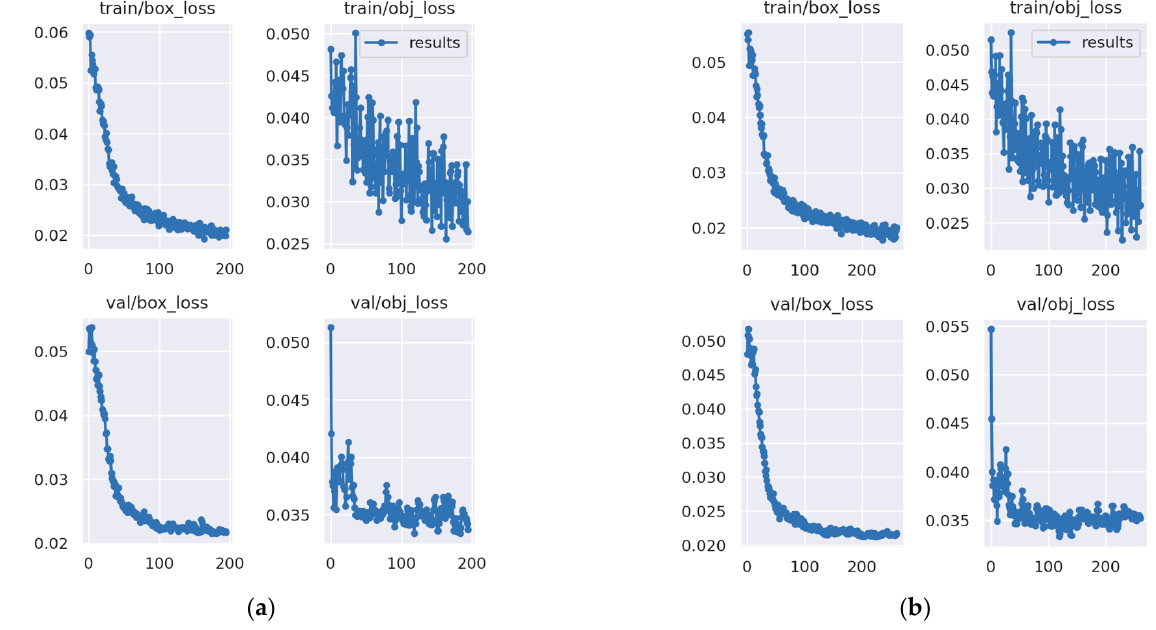
Figure 17. ( a ) GIoU decline curve during training; ( b ) CIoU loss decline curve during training. It can be seen in Table 1 that after using the CIoU loss function, the mAP obtained by YOLOv5 for different IoU non-maximum suppression in GPR target detection was larger than that of GIoU , which shows that under different IoU NMS, CIoU-YOLOv5 has better has higher positioning accuracy, which lays the foundation for us to accurately locate for- eign objects in underground soil. Table 1. mAP values of GIoU-YOLOv5 and CIoU-YOLOv5 under different IoU NMS. IoU